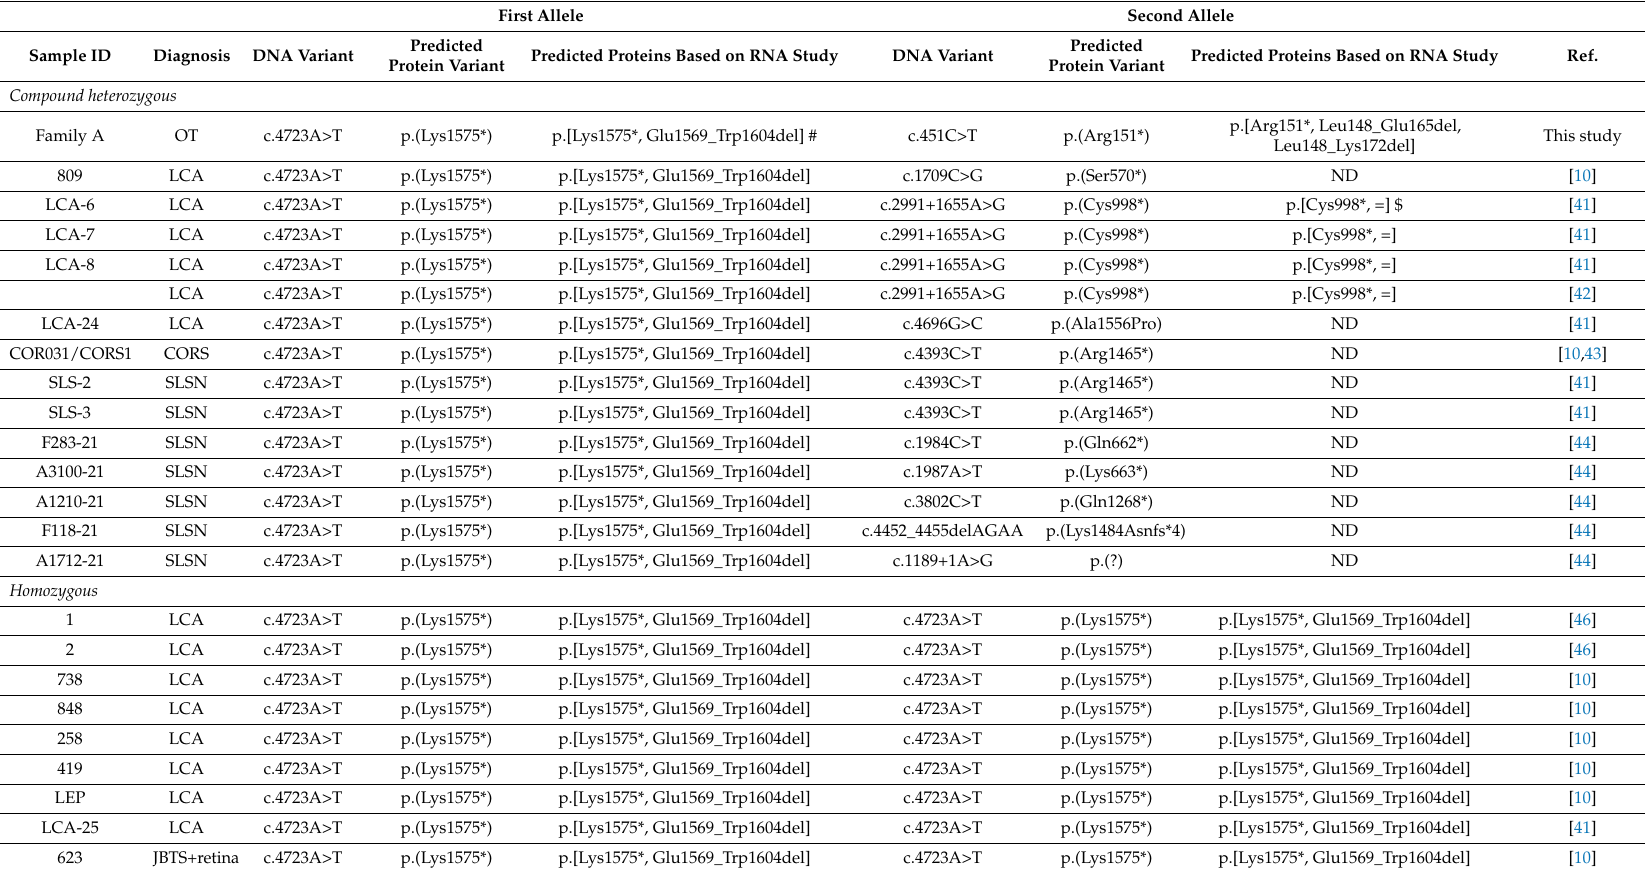
Table 2. Individuals harboring the c.4723A>T mutation in CEP290